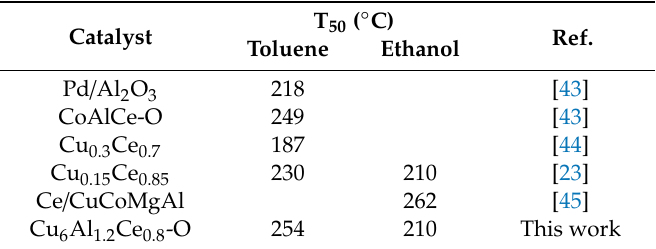
Table 5. Comparison of catalyst